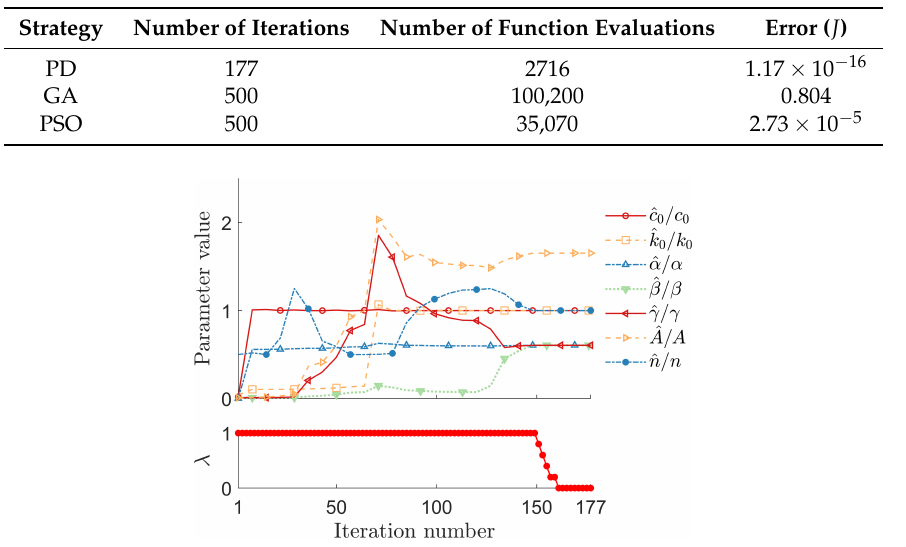
Figure 9. Evolution of parameter estimates (normalized relative to experimental values) for magnetorheological damper system using proportional–derivative